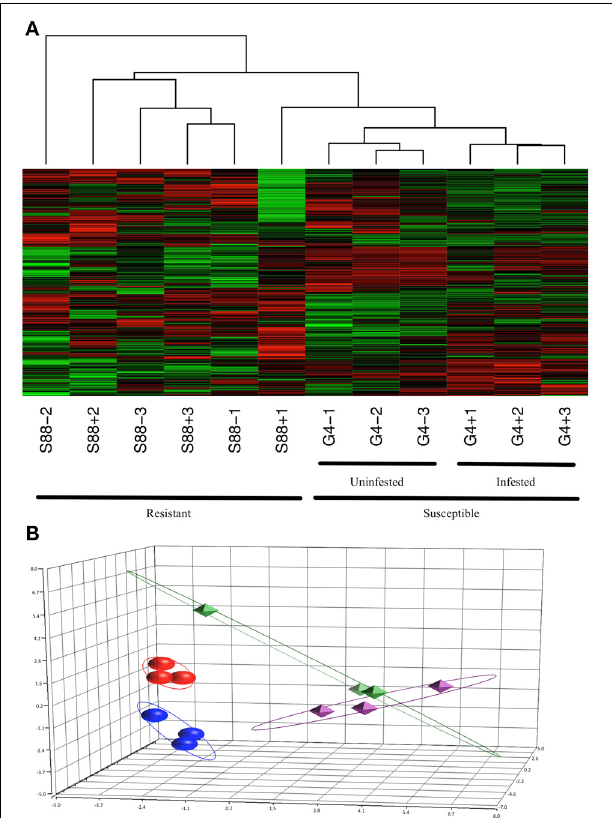
FIGURE 4 | Clustering of the kinome profiles of dark-eyed pupae of different phenotypes and infestation statuses. (A) Hierarchical clustering of kinome datasets. (1 − Pearson correlation) was used as the distance metric, while McQuitty linkage was used as the linkage method. Each column represents the kinome activity of individual pupae ( n = 3/treatment). For the most part, cluster analysis first segregated kinome profiles by colony phenotype (S88: resistant; G4: susceptible), and then segregated G4 pupae by presence or absence of Varroa infestation. (B) Principal component analysis. The first three principal components are shown. Separation of the samples on the basis of phenotype is clearly observed, with further distinction within the susceptible, but not resistant, samples on the basis of infestation status. The points are as follows: red, G4 + ; dark blue, G4 − ; green, S88+; purple, S88 − . The proportions of variance explained by the first, second, and third principal components were 22.5%, 14.8%, and 11.2%,